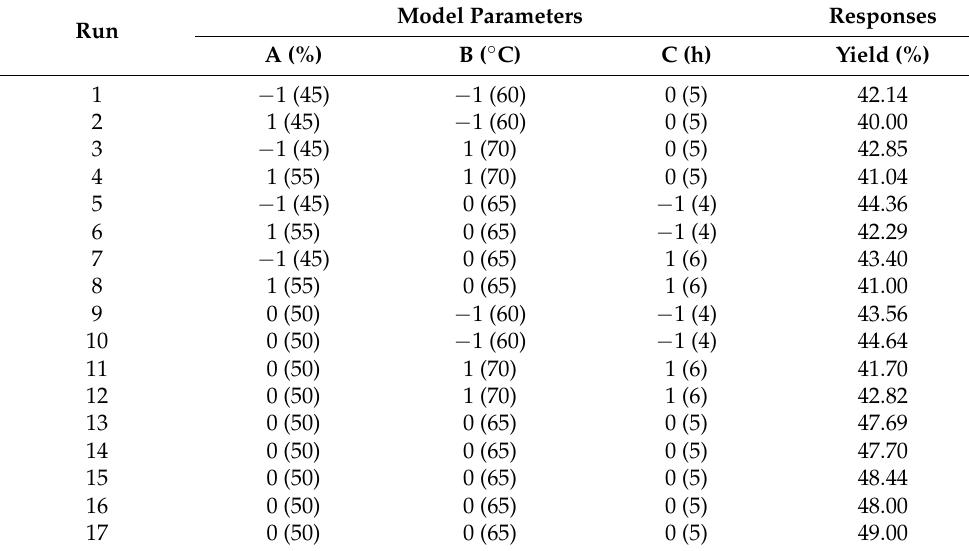
Table 3. Experimental designs and